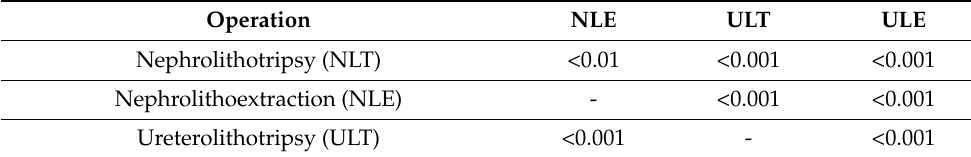
Table 1. Significance levels ( p ) of differences in the incidence of complications in various types of endoscopic treatment.